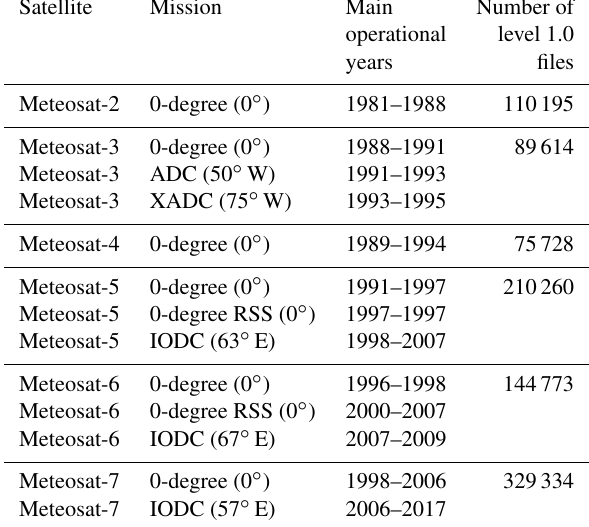
Table 1. List of satellite names, operational mission with nominal sub-satellite longitude position in brackets, the main years of oper- ation (EUMETSAT, 2014), and the total number of level 1.0 data files in the archive for a given satellite.